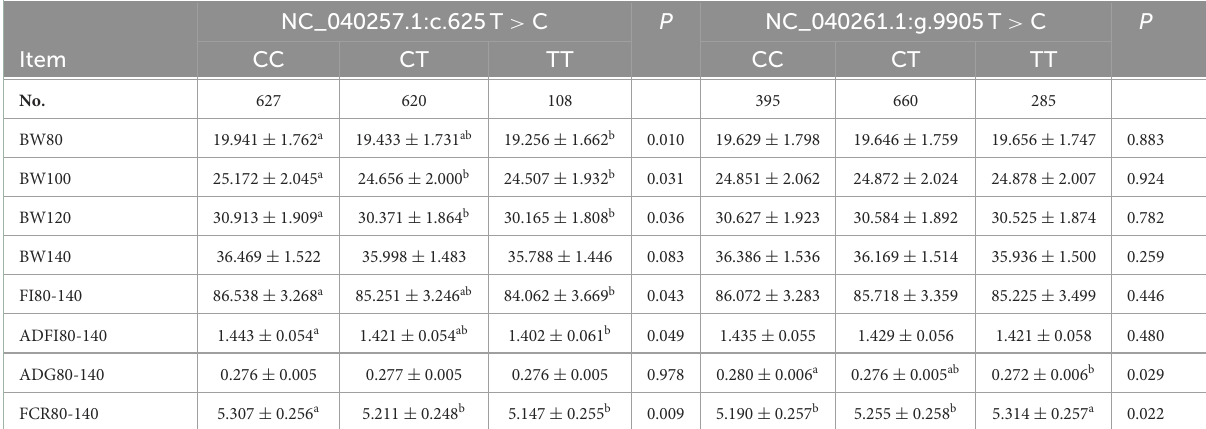
TABLE 3 The association between SHISA3 and RFC3 polymorphism and traits related to feed conversion